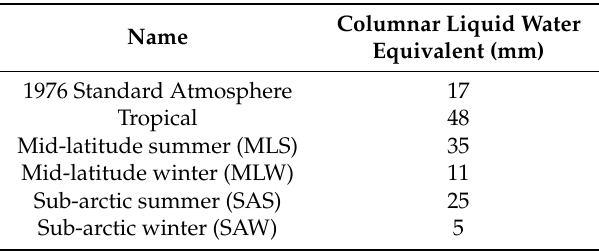
Table 1. The dependence of atmospheric water vapor in the MODerate resolution atmospheric TRANsmission (MODTRAN) standard cases [15].